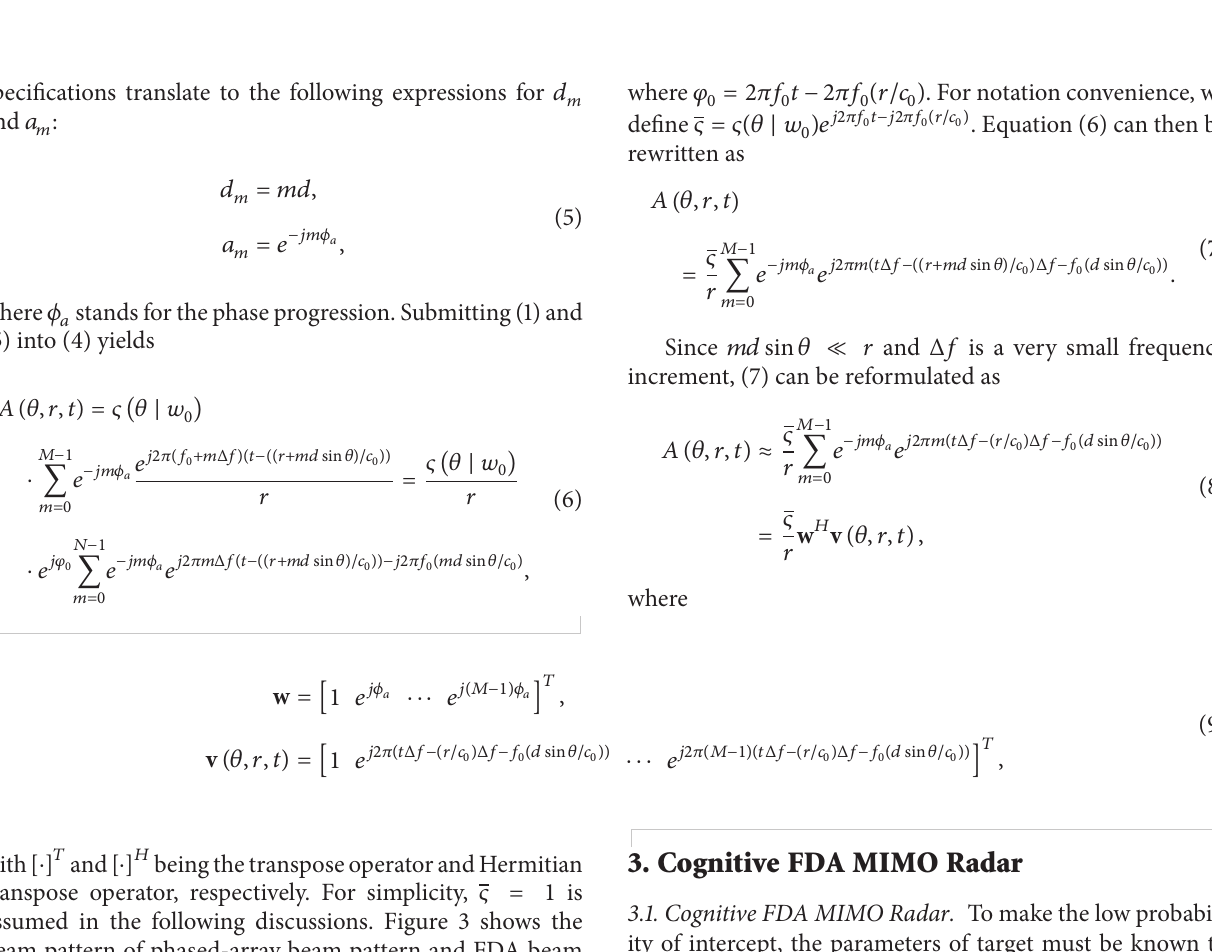
Figure 3: Comparative beam pattern between conventional phased array and FDA, where 𝑡 = 0 , Δ𝑓 = 3 kHz, 𝑀 = 8 , 𝑓 0 = 10 GHz, and 𝑑 = 𝜆/2 with 𝜆 being the wavelength assumed. (a) Phased-array radar; (b) FDA